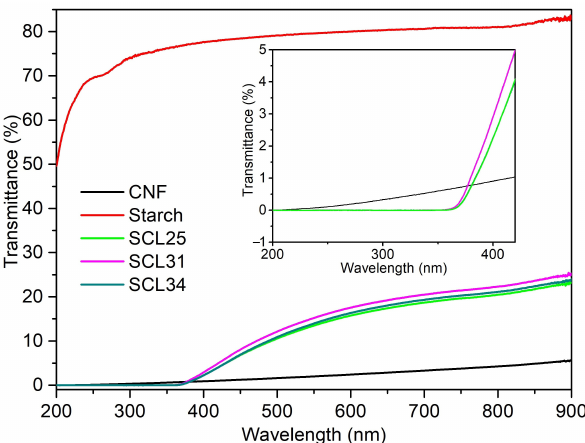
Figure 5. Transmittances of neat and composite